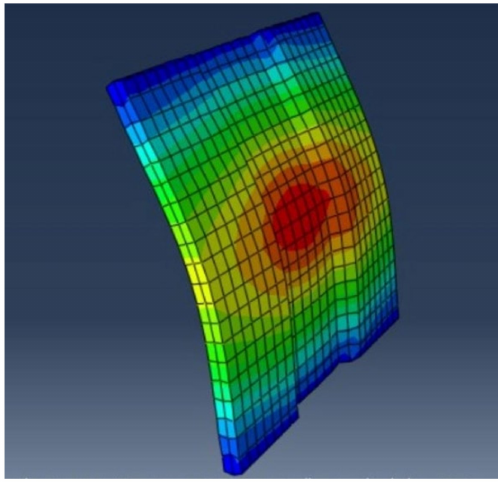
Figure 20. Crack pattern of geopolymer ferrocement panels.